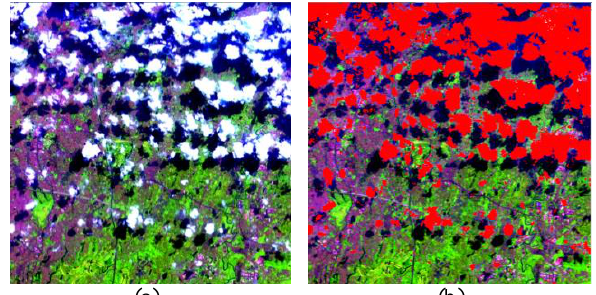
Figure 11. The result of cloud masking using QA band. Red colour indicates cloud region.